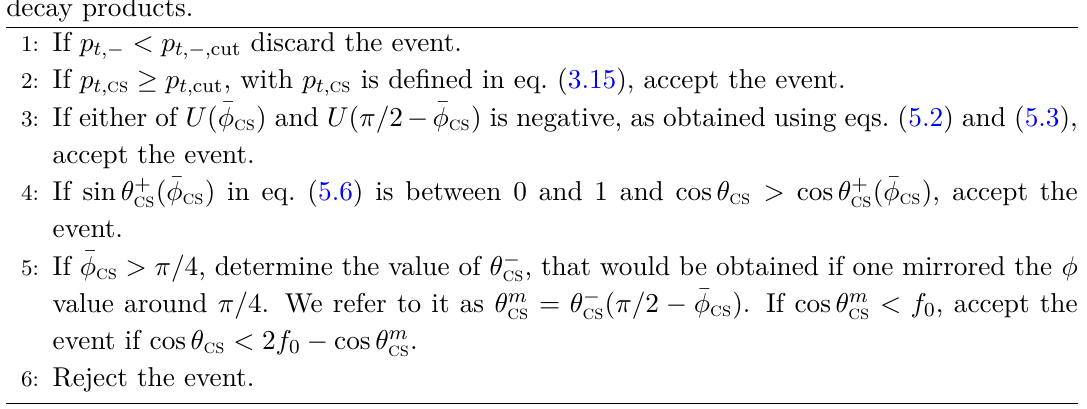
) cut algorithm to determine H and a minimum p requirement, p ≡ p − ∆ on both t cut t t, − , cut t cut